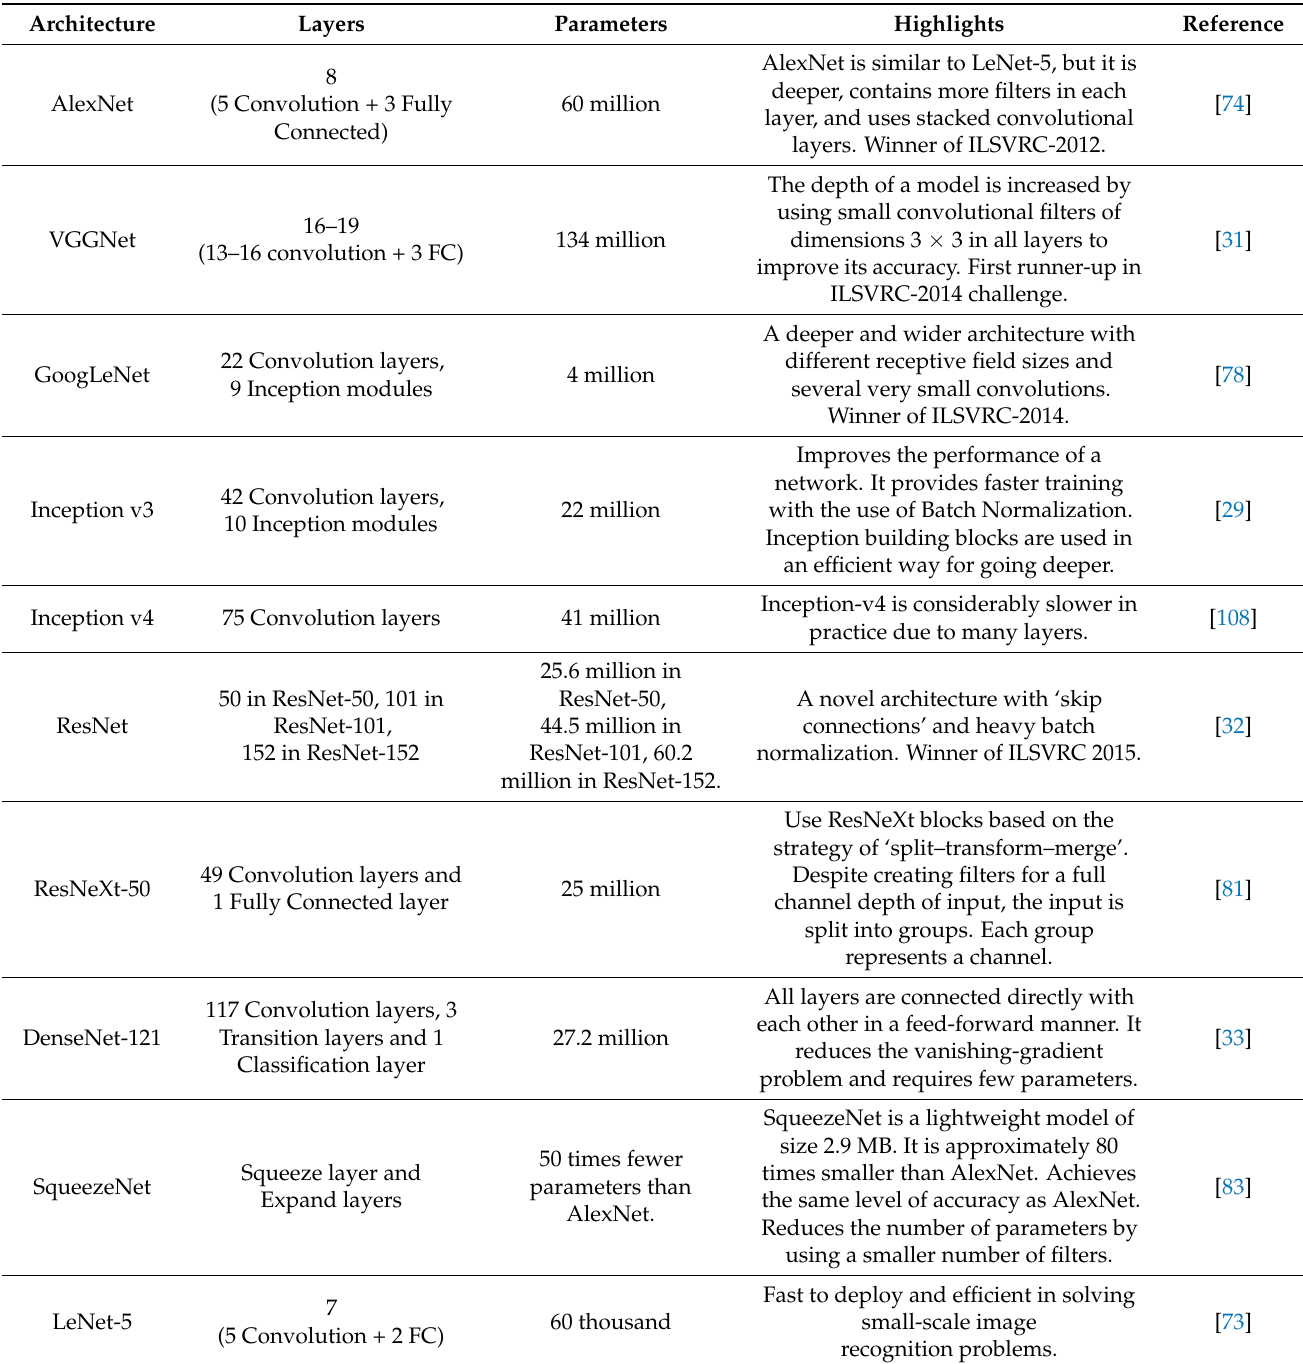
Table 3. Comparison of popular CNN